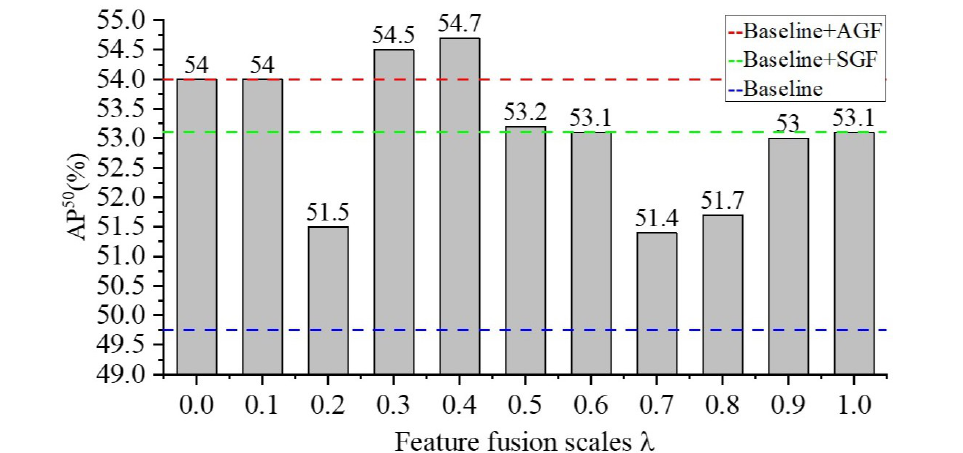
Figure 11. Performance of different feature fusion